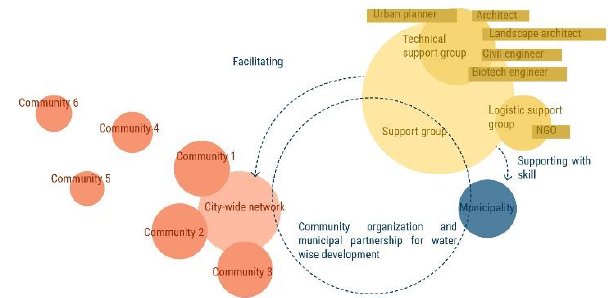
Figure 4: City-wide network and support